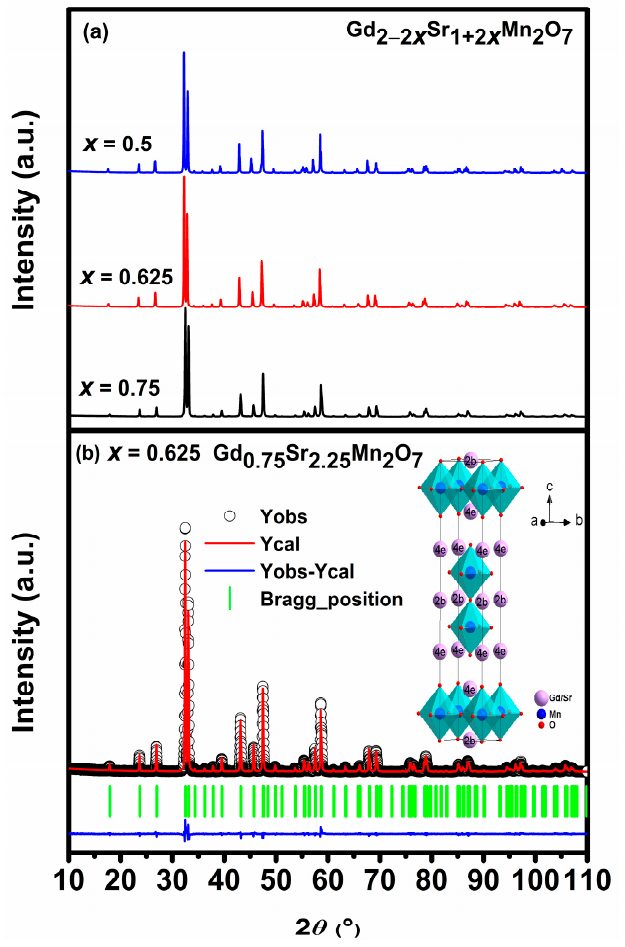
Figure 1. ( a ) Powder XRD patterns for Gd 2 − 2 x Sr 1+2 x Mn 2 O 7 ( x = 0.5, 0.625, 0.75). ( b ) Rietveld refinement pattern for x = 0.625. The inset shows the crystal structure of the unit cell. Figure 2a–c presents the FE-SEM polished surface micrographs of sintered pellets of Gd 2 − 2 x Sr 1+2 x Mn 2 O 7 ( x = 0.5, 0.625, 0.75) samples. The insets of Figure 2a–c are the fractured surface micrographs. Samples x = 0.625 and x = 0.75 show similar polished